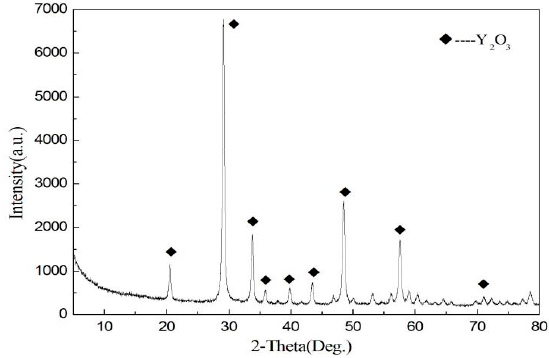
Figure 10. XRD pattern of the precursor.